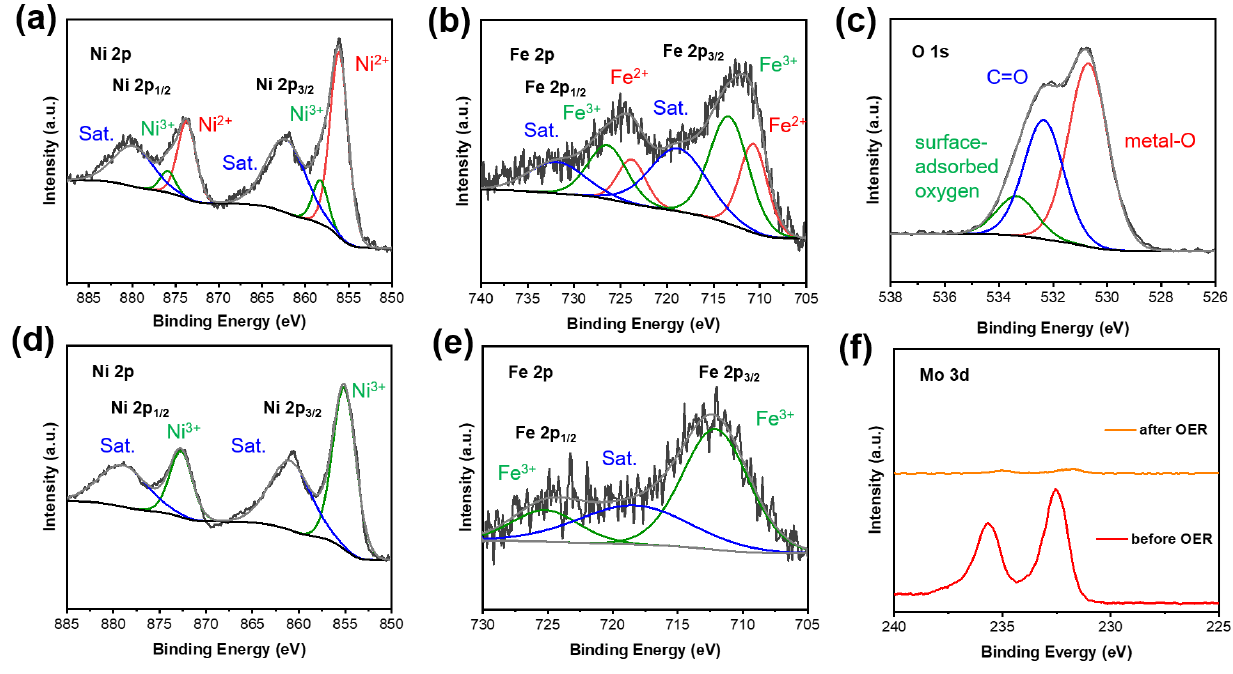
Figure 3. XPS: ( a ) Ni 2p, ( b ) Fe 2p, and ( c ) O 1s spectra of NiFe 2 O 4 /NiMoO 4 ; ( d ) Ni 2p and ( e ) Fe 2p spectra of NiFe 2 O 4 /NiMoO 4 after OER testing for 3 h; ( f ) Mo 3D spectra of NiFe 2 O 4 /NiMoO 4 before OER testing and after OER testing.